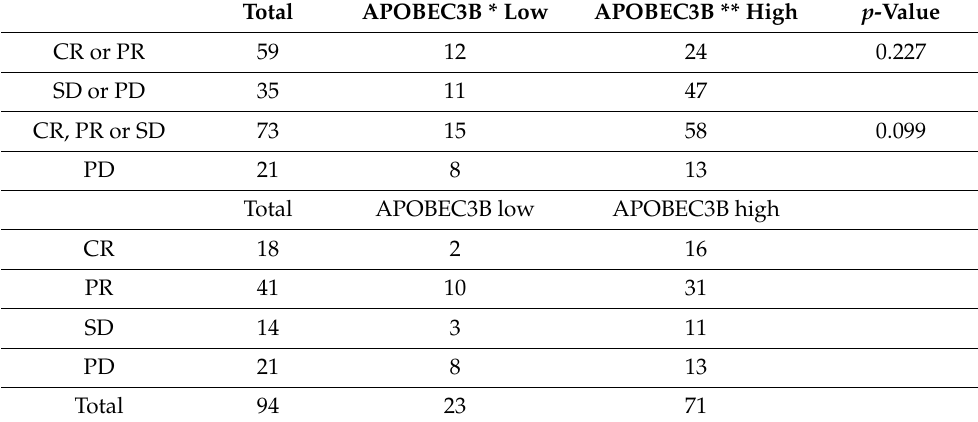
Table 4. Chemotherapy response according to APOBEC3B